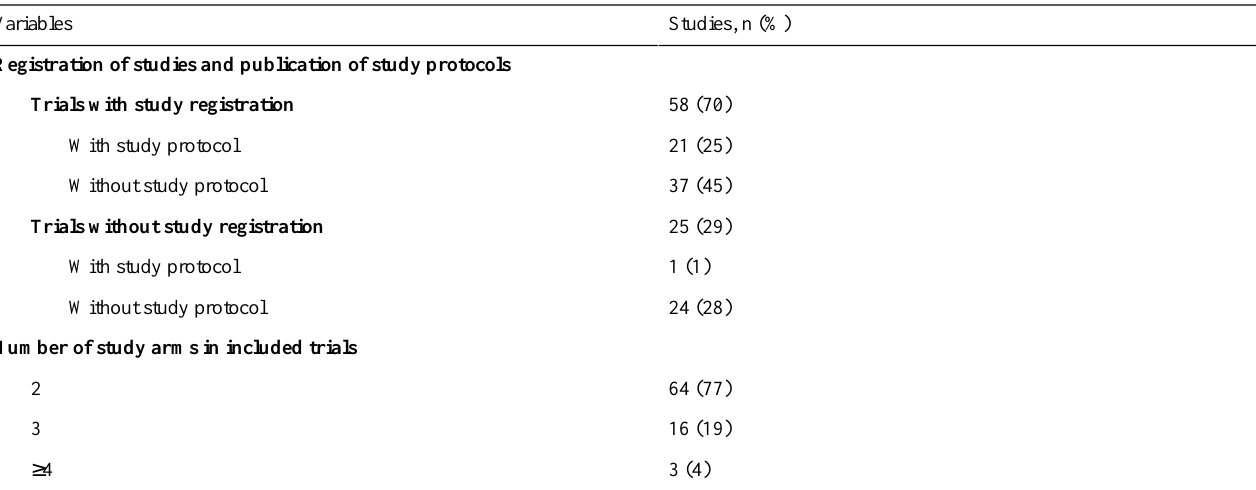
Table 1. General study characteristics